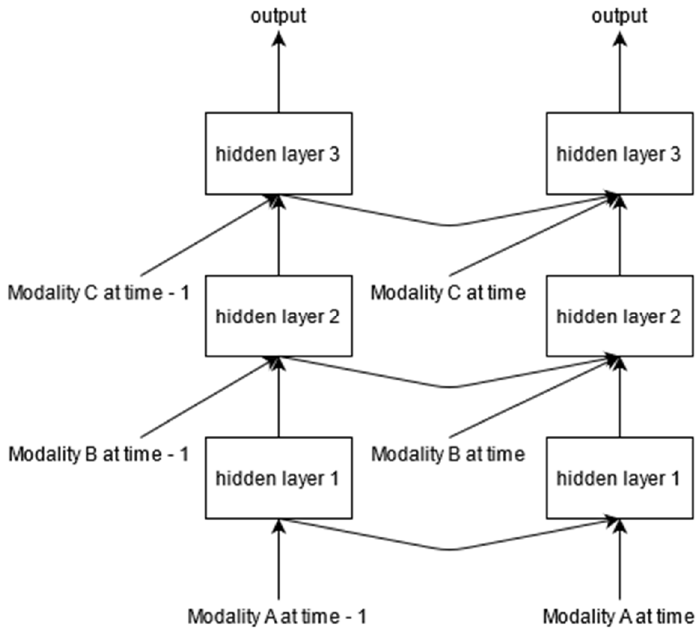
Figure 5. Proposed model for multimodal expression recognition.